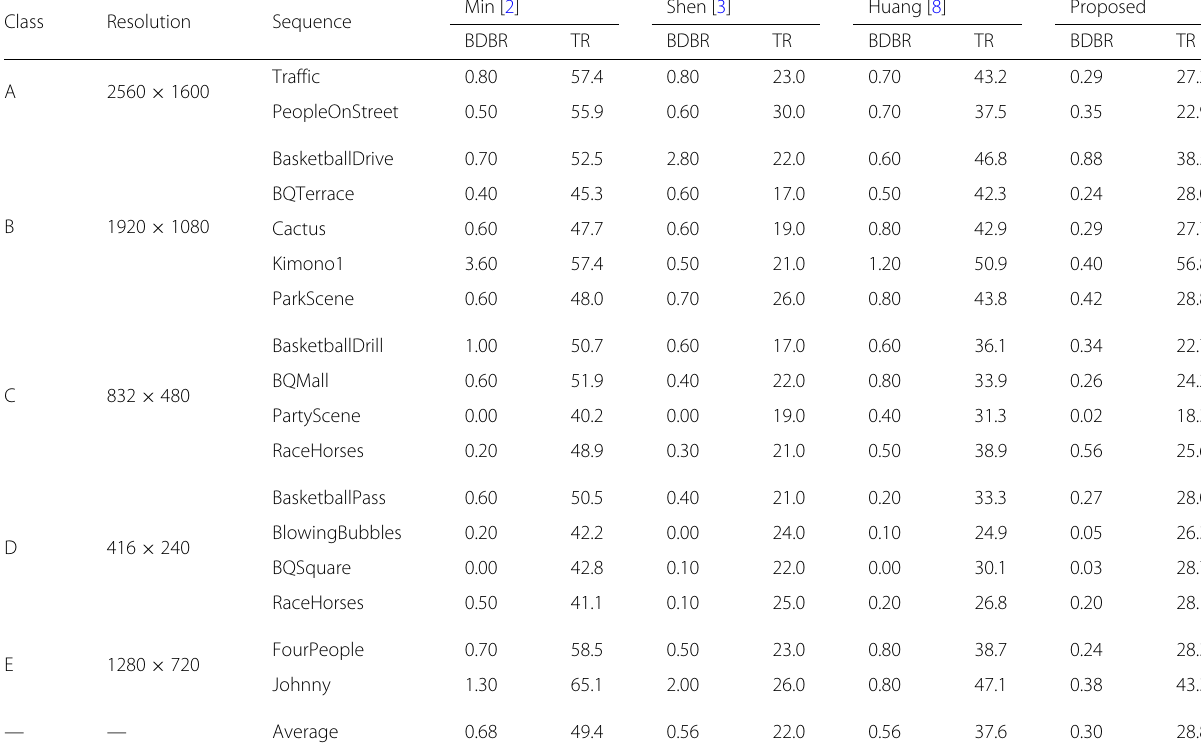
Table 3 Comparison of the proposed fast CU size decision algorithm against the existing algorithms and HM